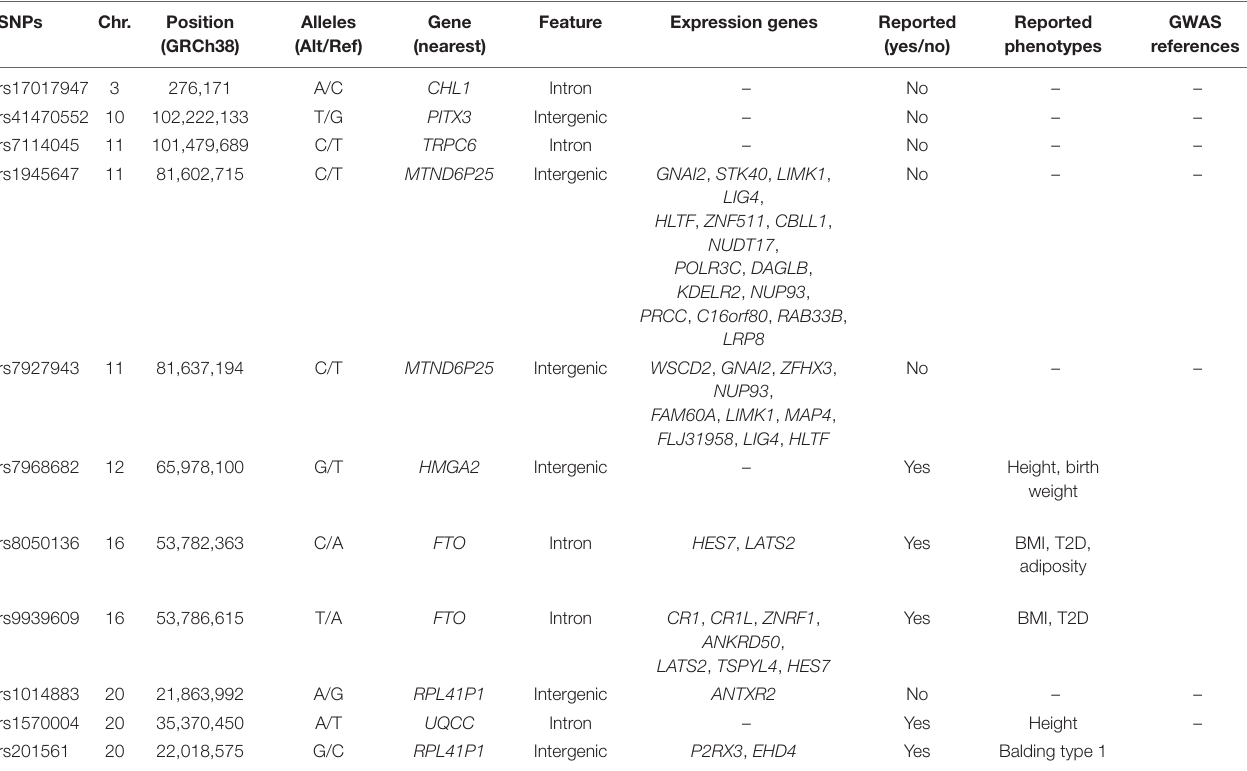
TABLE 5 | Characteristics of the significant SNPs. SNPs